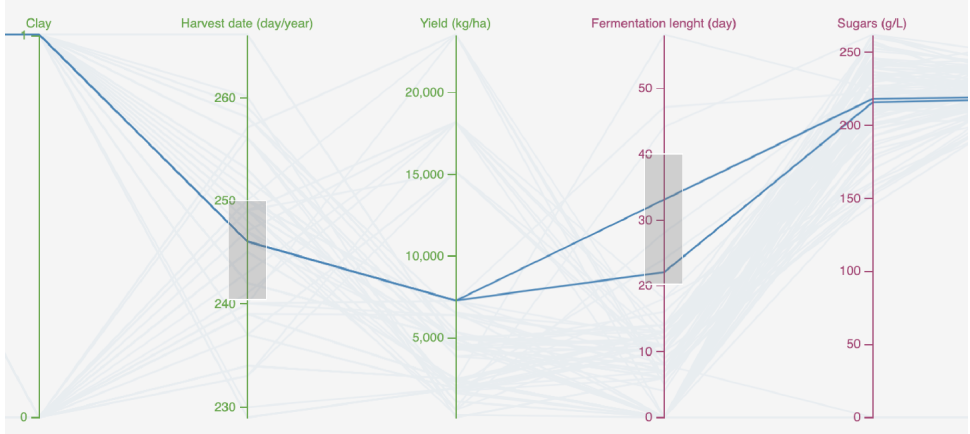
Figure 5. A section of the parallel coordinates from Figure 4b where the brushing technique is applied to filter the data. Due to linked data, such a filter in the parallel coordinates also affect the other